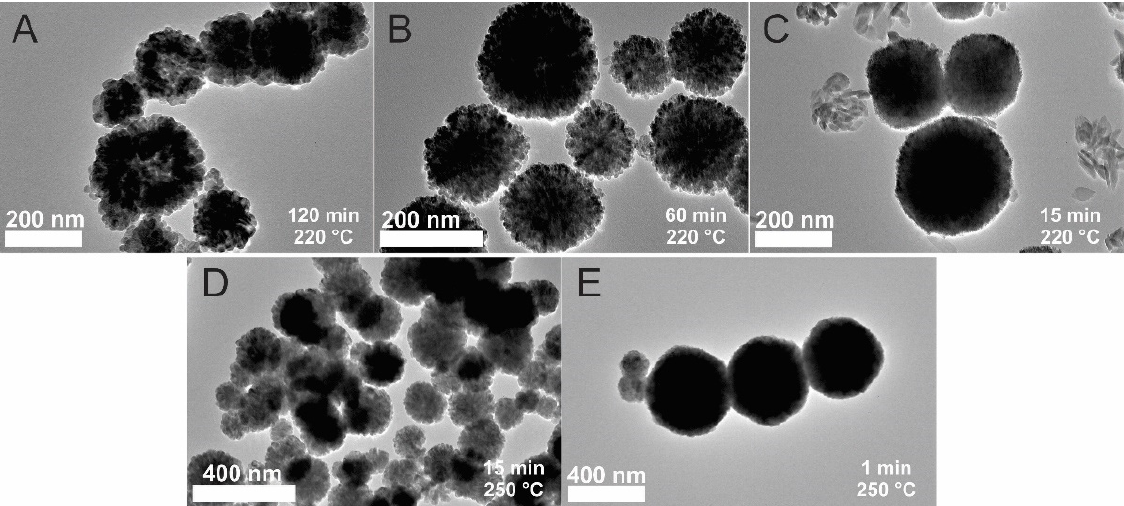
Figure 5. TEM images of the synthesized samples without PEG: 220 °C, 120 min ( A ); 220 °C, 60 min ( B ); 220 °C, 15 min ( C ); 250 °C, 15 min ( D ); 250 °C, 1 min ( E ). The scale bar for ( A – C ) is 100 nm, and the scale bar for ( D ) and ( E ) is 200 nm. Table 2. Comparison of the Fe 3 O 4 particle sizes synthesized without PEG at different temperatures and times. Particles refer to the whole sized spheres, and crystallites are the small grains of which the particles are comprised.